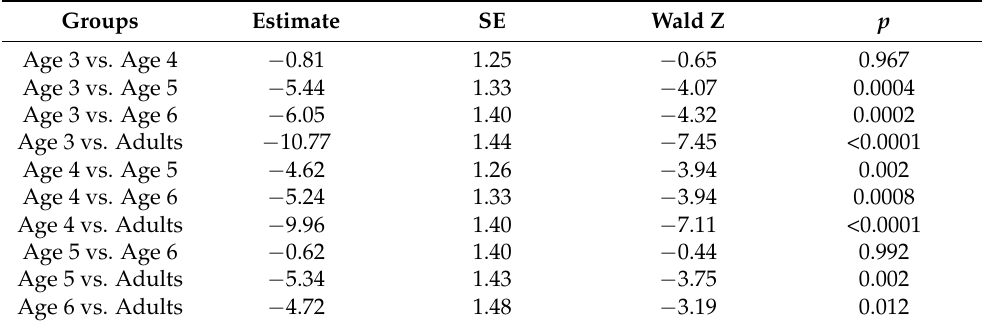
Table 8. Summary of the age factor in the mixed effects logistic regression model for PASSIVE RC S .